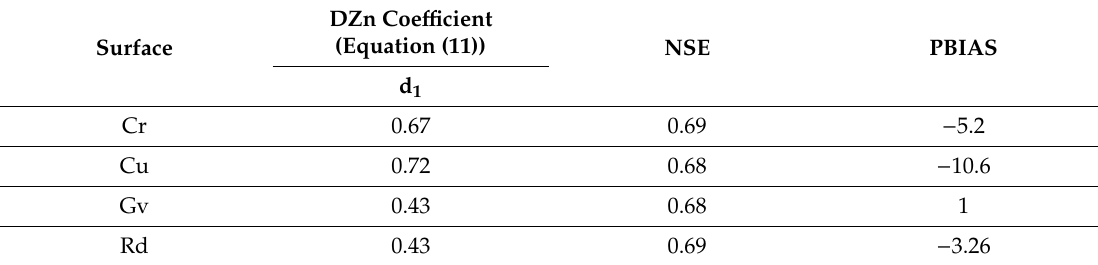
Table A5. Optimized MEDUSA2.0 model coe ffi cient values and goodness of fit statistics for DZn.